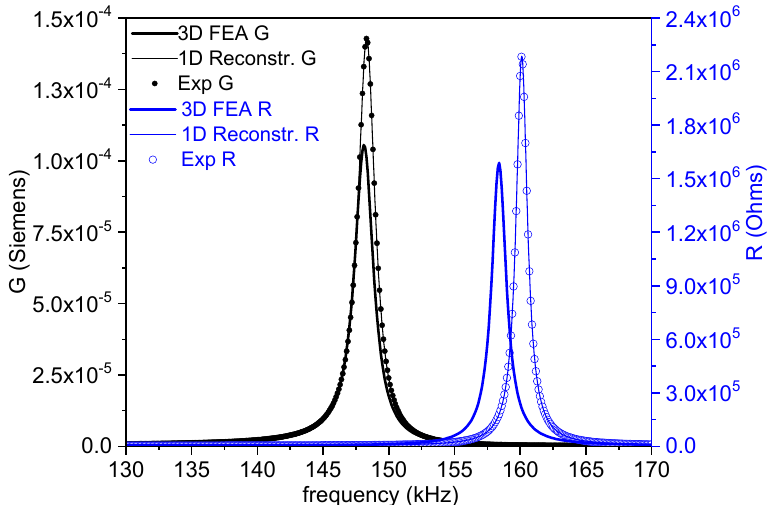
Figure 7. Fundamental thickness extensional resonance of a thickness-poled and excited thin disk. 3D FEA-modeled im- pedance spectrum: ( a ) ( Z , θ ) plot; and ( b ) equivalent ( R , G ) plot of a disk with a diameter of 12 mm and a thickness of 1.00 mm, shown as thick lines. The two types of plot also show the experimental spectrum (symbols). Figure ( b ), ( R , G ) plots showing the reconstructed spectrum after the calculation of the parameters (1D model) as thin lines. Black symbols and lines ( Z and G data) can be read in the left-y-axis, and blue ones ( θ and R data) are in the right-y-axis.